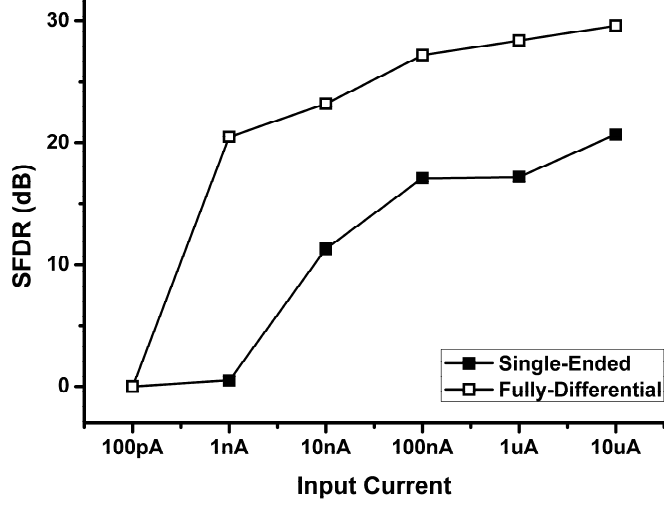
Figure 16. Input current versus SFDR of SE and FD